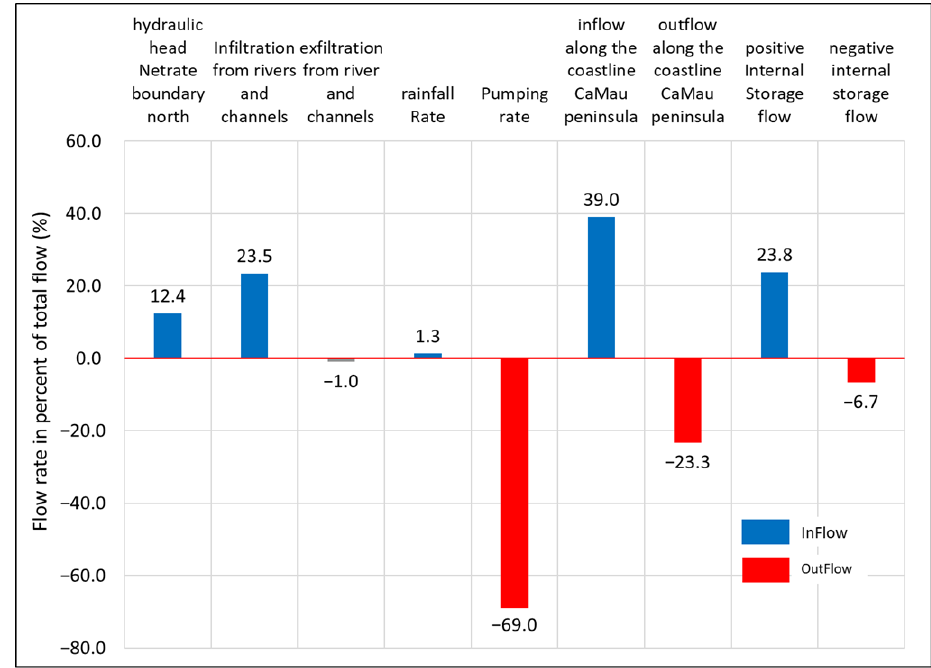
Figure 11. Groundwater balance of the model (components in percent of total flow).